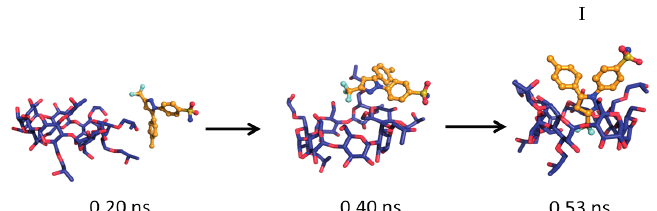
Figure 3. The key steps in the formation of the 1:1 CCB/HP- β -CD inclusion complex (Structure I).